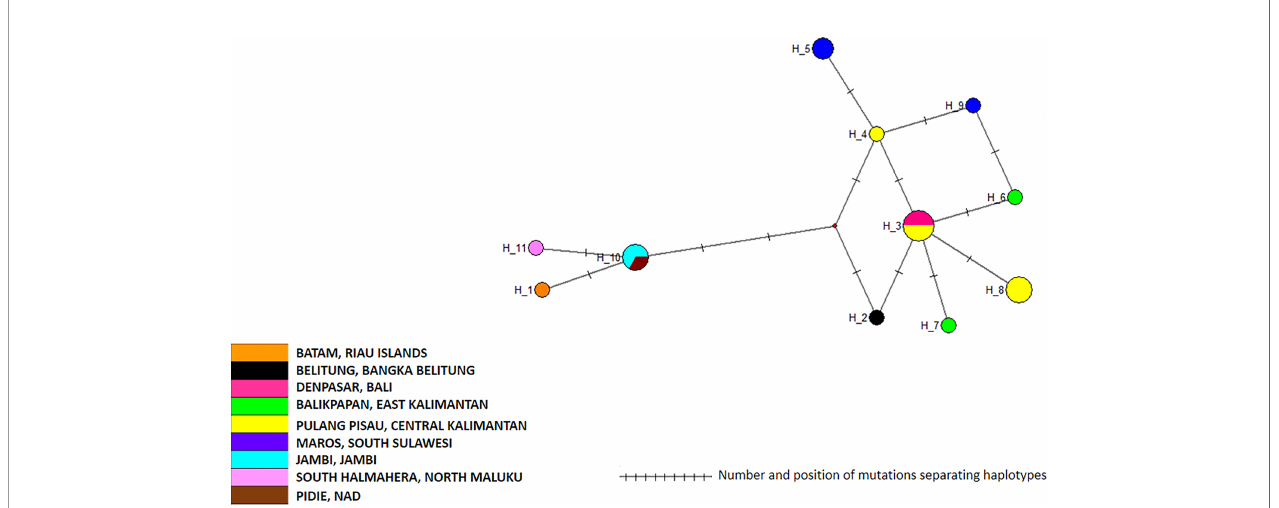
FIGURE 7 | Network of Aedes albopictus cox 1 haplotypes. The fi gure represents the frequency of each haplotype of the cox 1 gene of Ae. albopictus in the regions sampled. The network represents the number of mutations between the haplotypes and their location on the gene